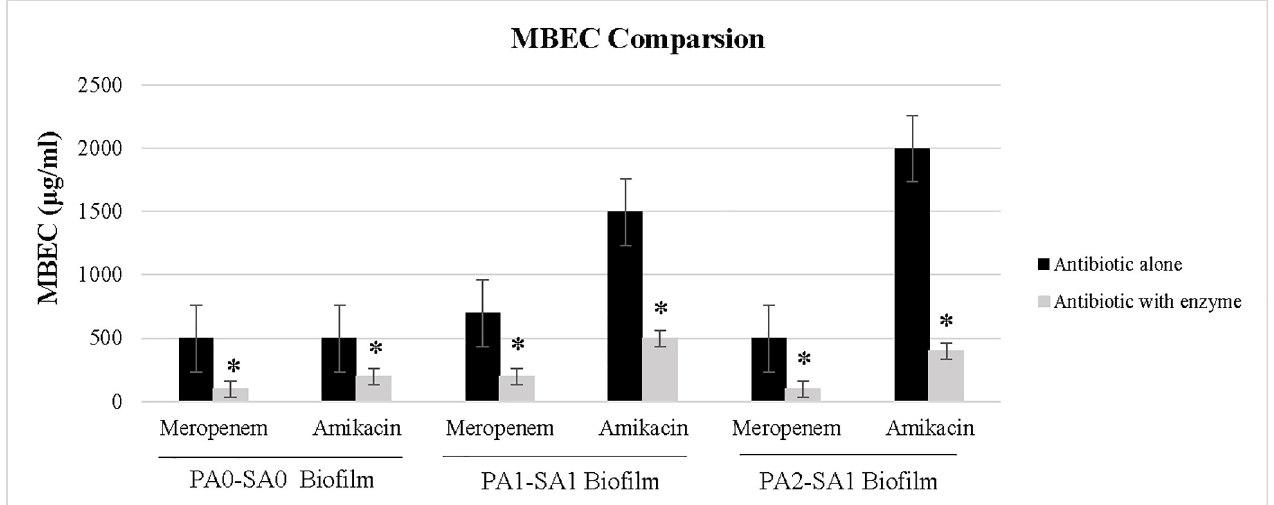
Fig 6. Comparison of MBEC results. Data shown represent MBECs of meropenem and amikacin alone (Antibiotic alone) and in combination with trypsin/ DNase I mixture (Antibiotic with enzyme). MBECs of both antibiotics decreased significantly ( p < 0.05) when combined with trypsin/DNase I mixture. Error bars represent the standard errors of the